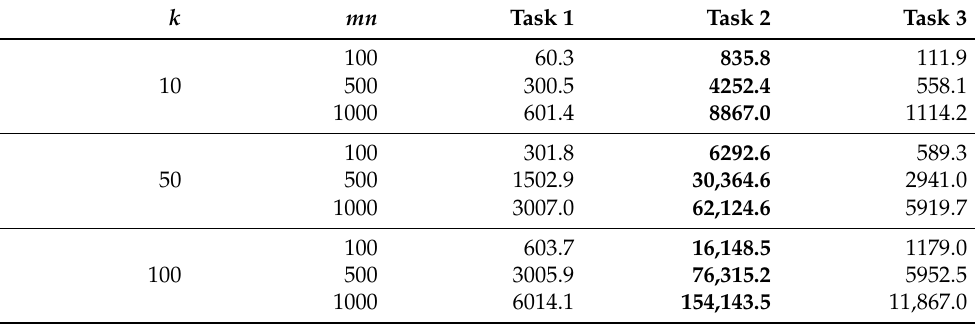
Table 6. Running time (s) of baseline algorithm (naive secure CWC). Task 1: computing B i s. Task 2: sorting B i s. Task 3: feature selection.